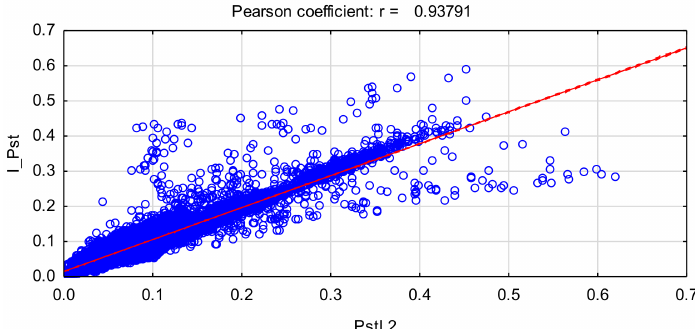
Figure 4. Spread chart of cluster 1 data for the flicker indicator and the short-term flicker severity for phase L2 in